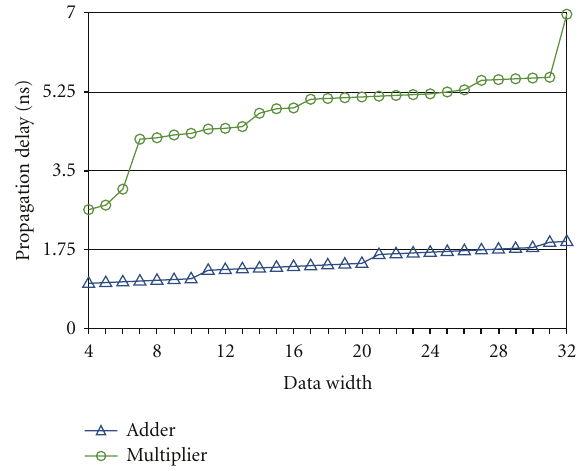
Figure 2: Delay for 32-bit resources (Altera Cyclone-III).